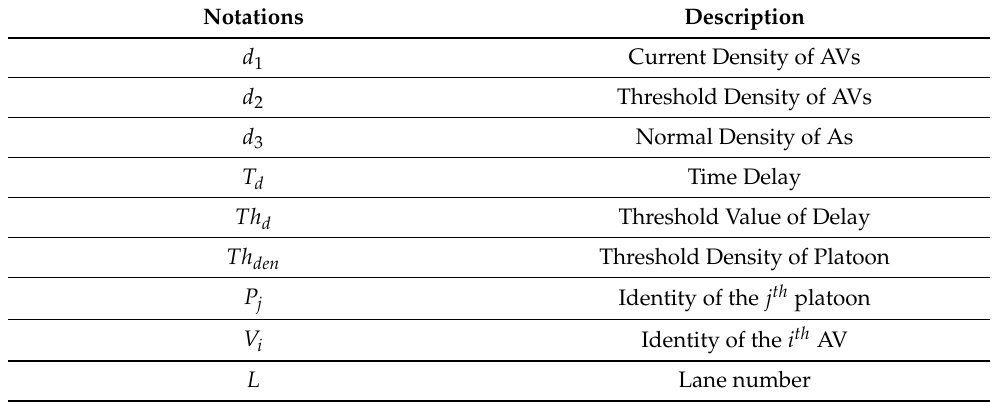
Figure 2. Flow diagram of proposed model. Table 1. Summary of